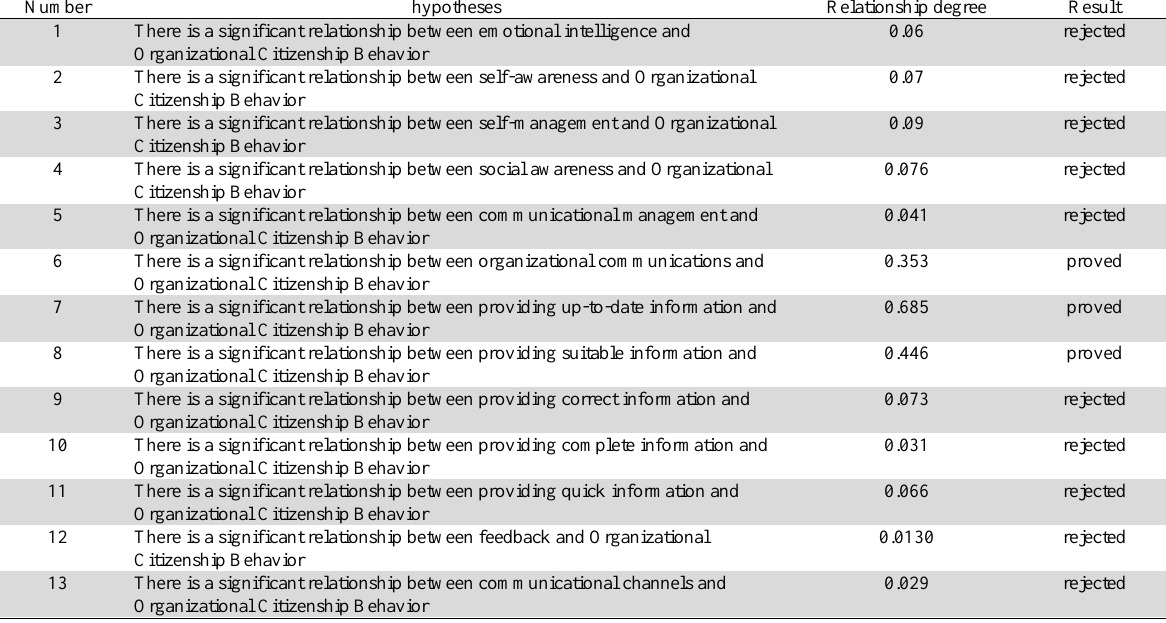
The summary of Pearson test for testing various